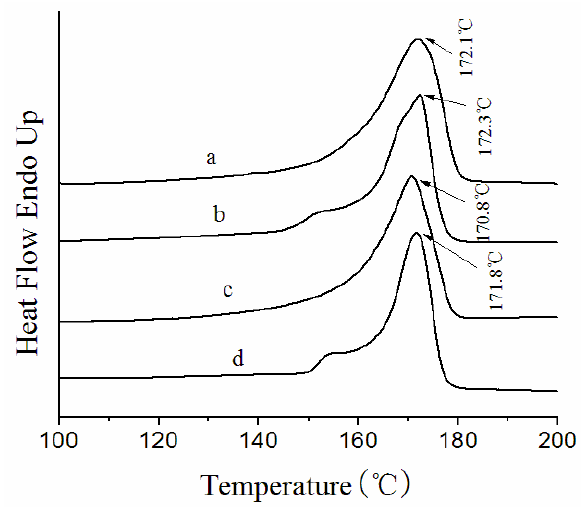
Figure 6. DSC curves of solution-cast membranes prepared under different conditions. ( a ) F5-60; ( b ) F5-140; ( c ) F5-7-60; ( d )